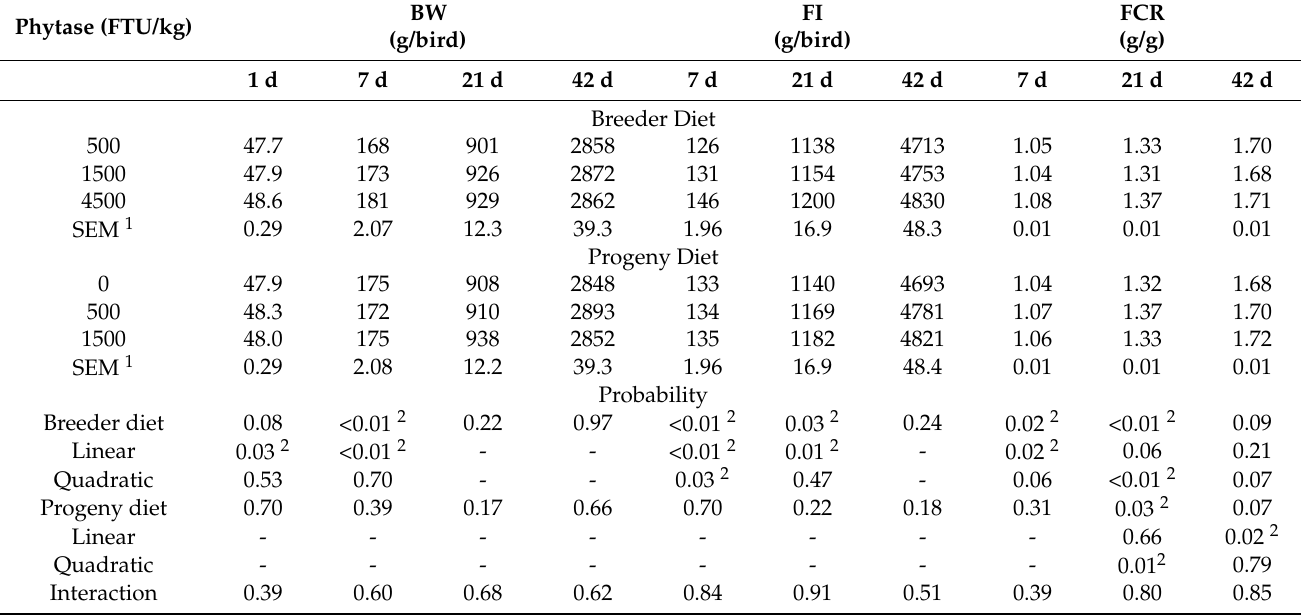
Table 6. Influence of phytase dose in diets of 38-week-old breeder hens and the subsequent effect of phytase dose in the diets of the progeny from hatching to day 42.